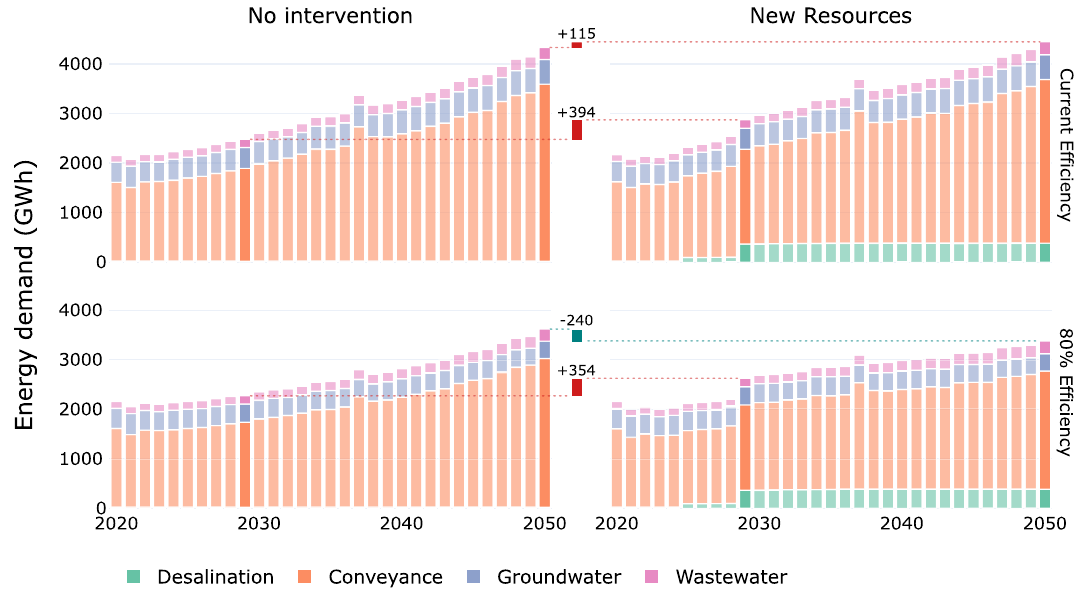
Fig. 8 Energy requirements for water uses in the No Intervention and New Resources scenarios (columns) in an increased evapotranspira- tion future (i.e. warmer future), and with and without improved pumping efficiency (rows). Years 2029 and 2050 are highlighted and the changes in total energy required are compared among